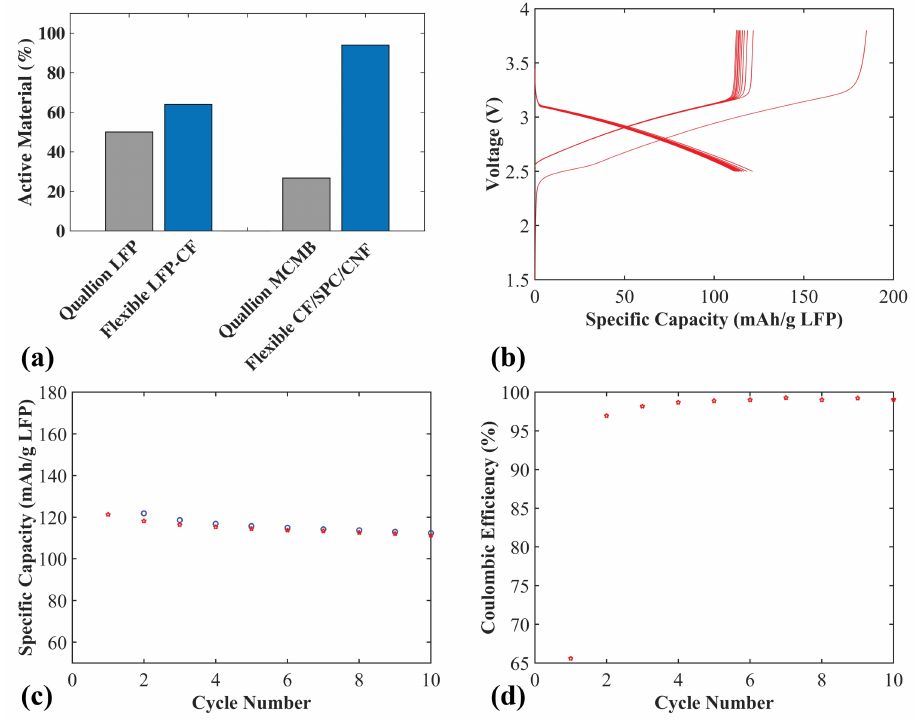
Figure 7. ( a ) Active material weight percentage of electrodes and current collector. Grey bars: Commercial Quallion LFP and MCMB electrodes. Blue bars: Flexible LFP-CF and CF/SPC/CNF electrode. Electrochemical performance of the LFP-CF versus CF/SPC/CNF electrodes cycled at 0.1 C: ( b ) voltage profiles; ( c ) specific capacity; and ( d ) coulombic